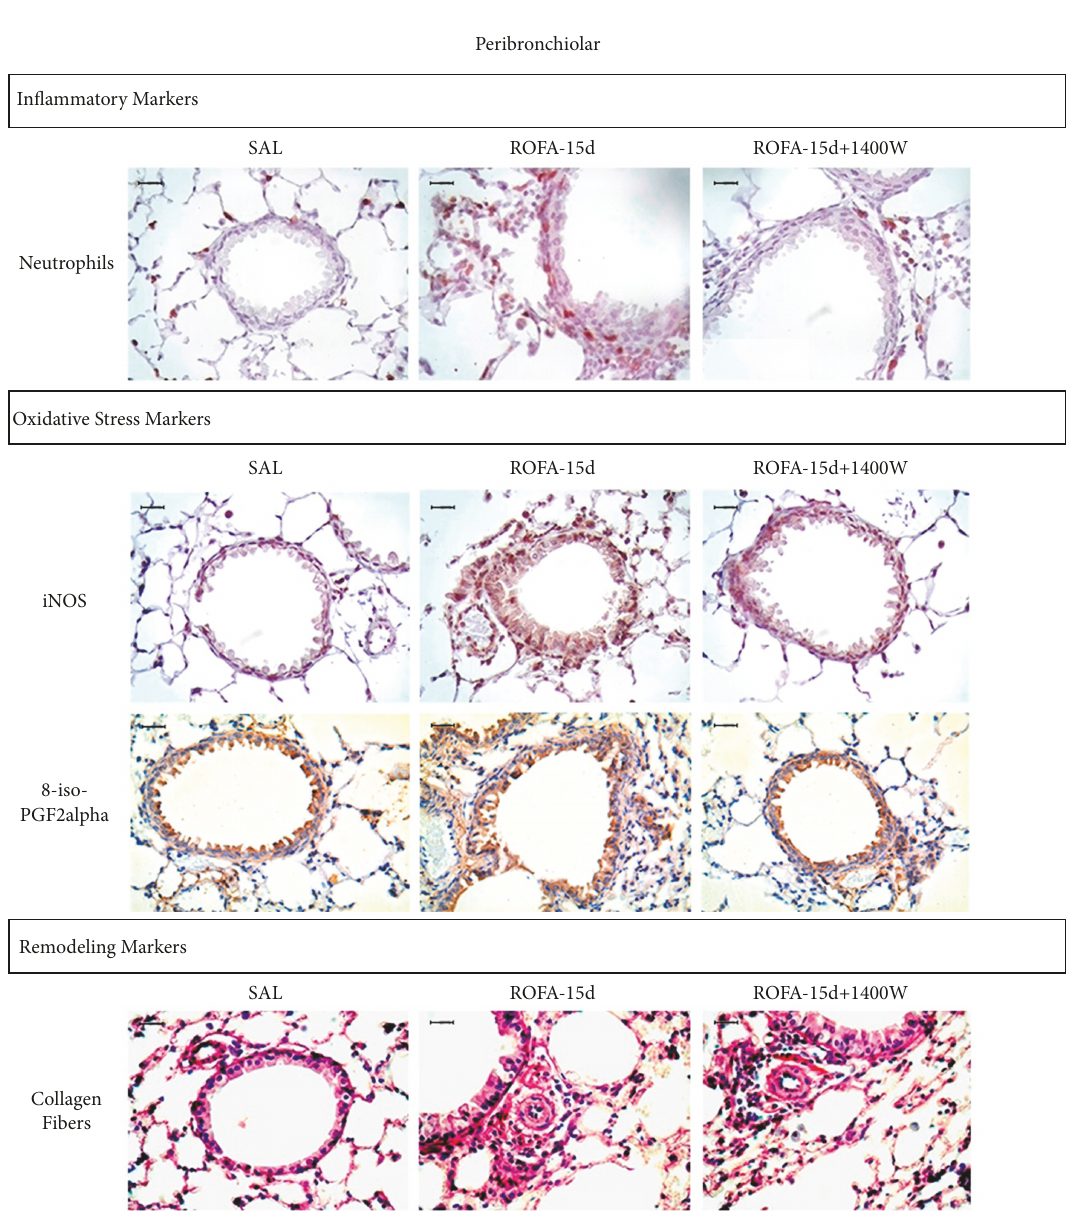
Figure 7: Representative photomicrographs of airway stained with immunohistochemistry to detect neutrophils, iNOS, isoprostane, and collagen fibers in all experimental